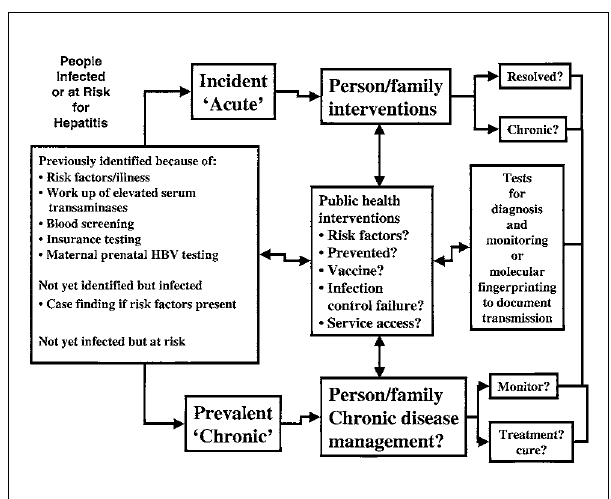
Figure 1) The population infected with or at risk for hepatitis, and component activities relating to prevention and care management